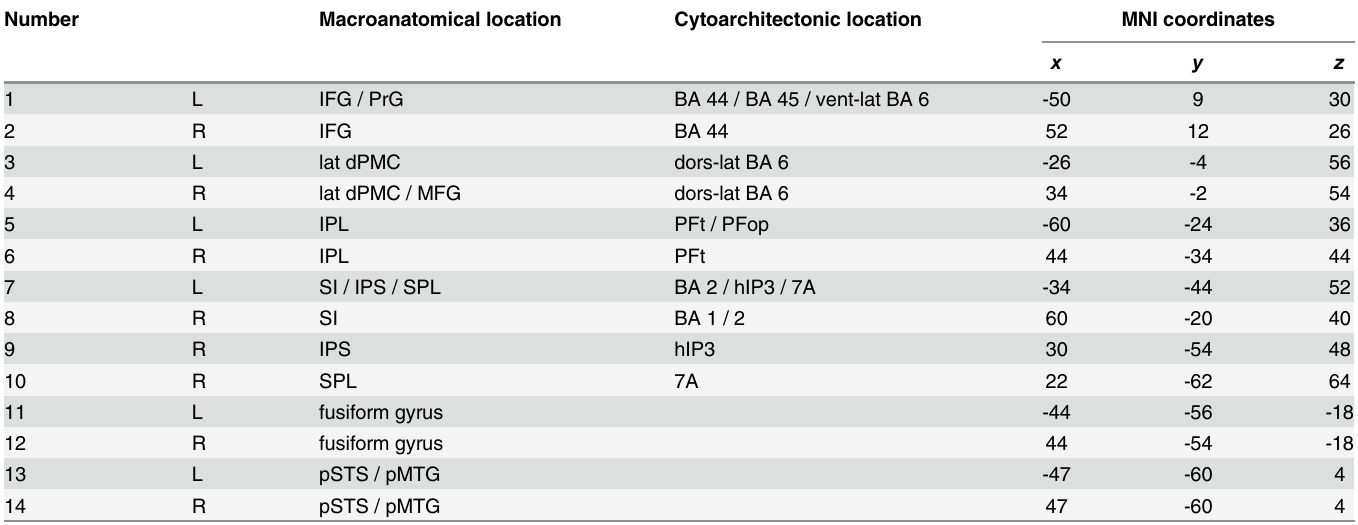
Table 2. Regions of interest of the action observation network.